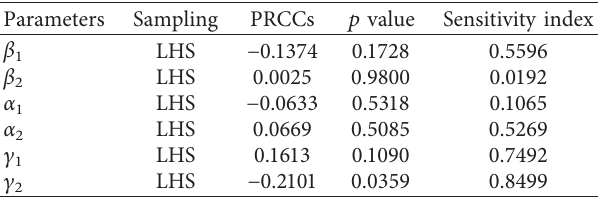
Table 6: PRCCs for R D 0 and six input parameters and the cor- responding sensitivity index.